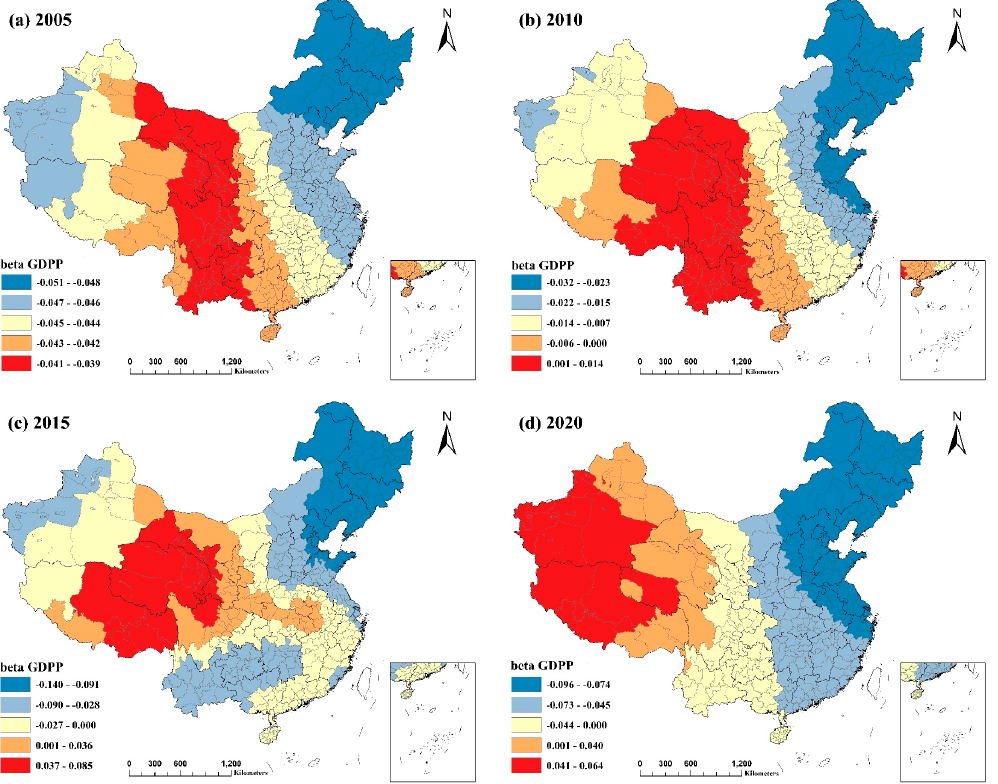
Figure 6. Spatial and temporal distribution of regression coefficients of GDP per capita in the MGWR model, 2005 − 2020: ( a ) spatial and temporal distribution of regression coefficients for GDP per capita in 2005; ( b ) spatial and temporal distribution of regression coefficients for GDP per capita in 2010; ( c ) spatial and temporal distribution of regression coefficients for GDP per capita in 2015; ( d ) spatial and temporal distribution of regression coefficients for GDP per capita in 2020.